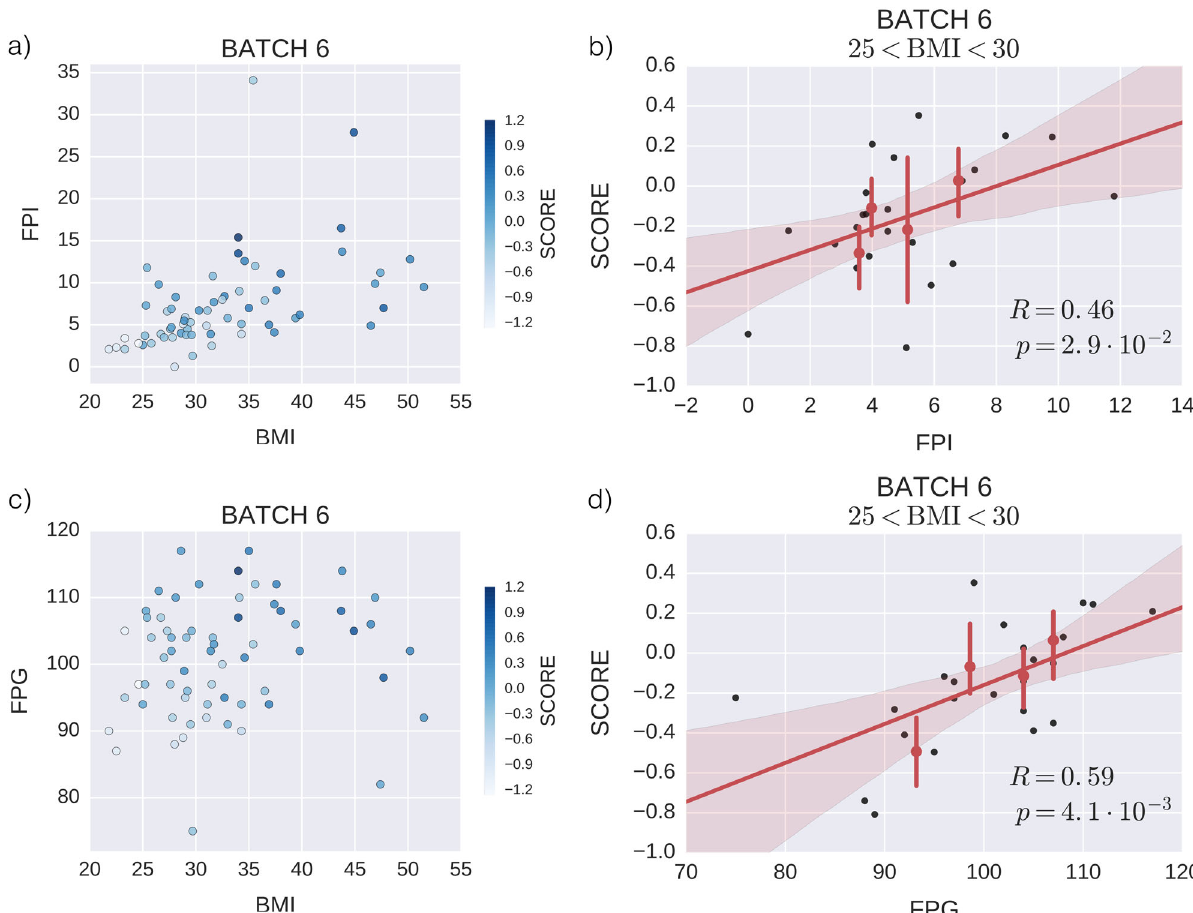
Fig. 5 The obesity score correlates with fasting plasma glucose (FPG) and fasting plasma insulin (FPI) in overweight patients. a , c Scatter plot of FPI a and FPG c vs. BMI for all patients in Batch 6. Each point corresponds to a patient and is colored according to its obesity score. b , d Regression plot of obesity score vs. FPI in panel b and vs. FPG in panel d , showing only patients from Batch 6 categorized as overweight. P -values are computed via two-sided null hypothesis of 0 slope. Data is binned using percentiles and displayed with 95% CI red error bars , with a red dot marking the mean value of the in each bin. The red solid line is the fi tted regression line, and the red shaded area corresponds to 95% CI of the regression line, computed via